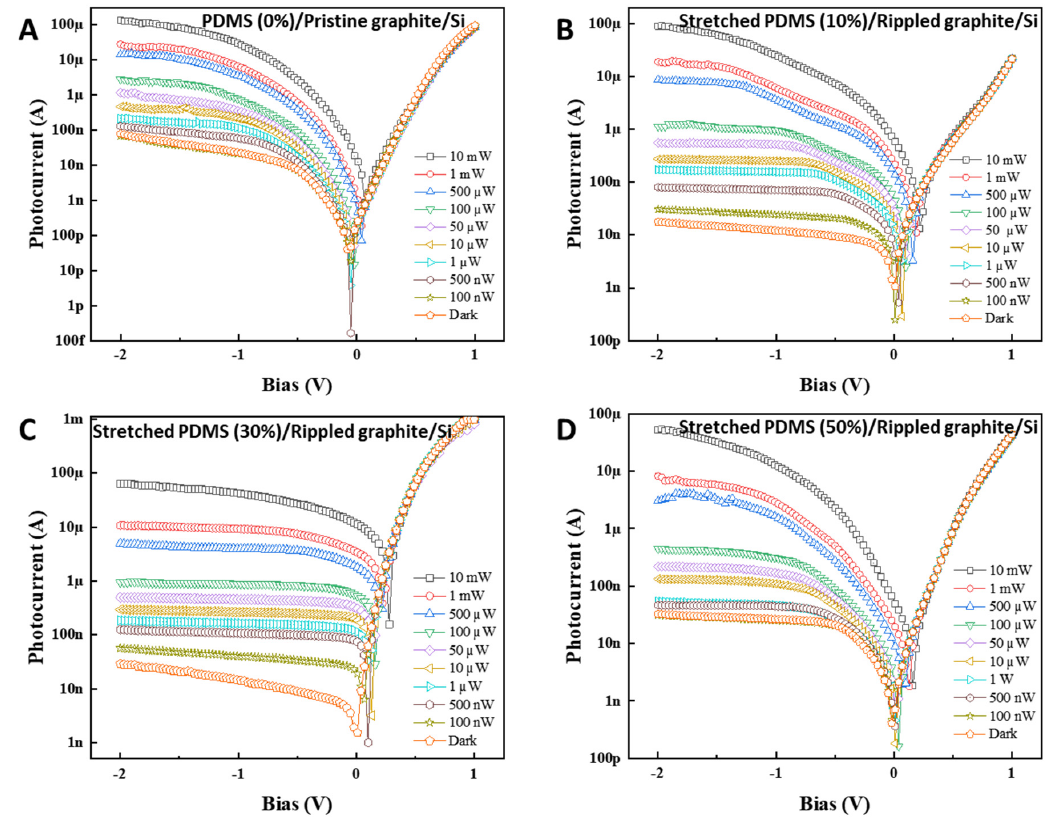
Figure 4. I–V curves of optical sensing devices based on ( A ) PDMS (0%)/pristine graphite/Si, ( B ) stretched PDMS (10%)/rippled graphite/Si, ( C ) stretched PDMS (30%)/rippled graphite/Si, and ( D ) stretched PDMS (50%)/rippled graphite/Si under dark and laser illumination at 532 nm wavelength with different power values.